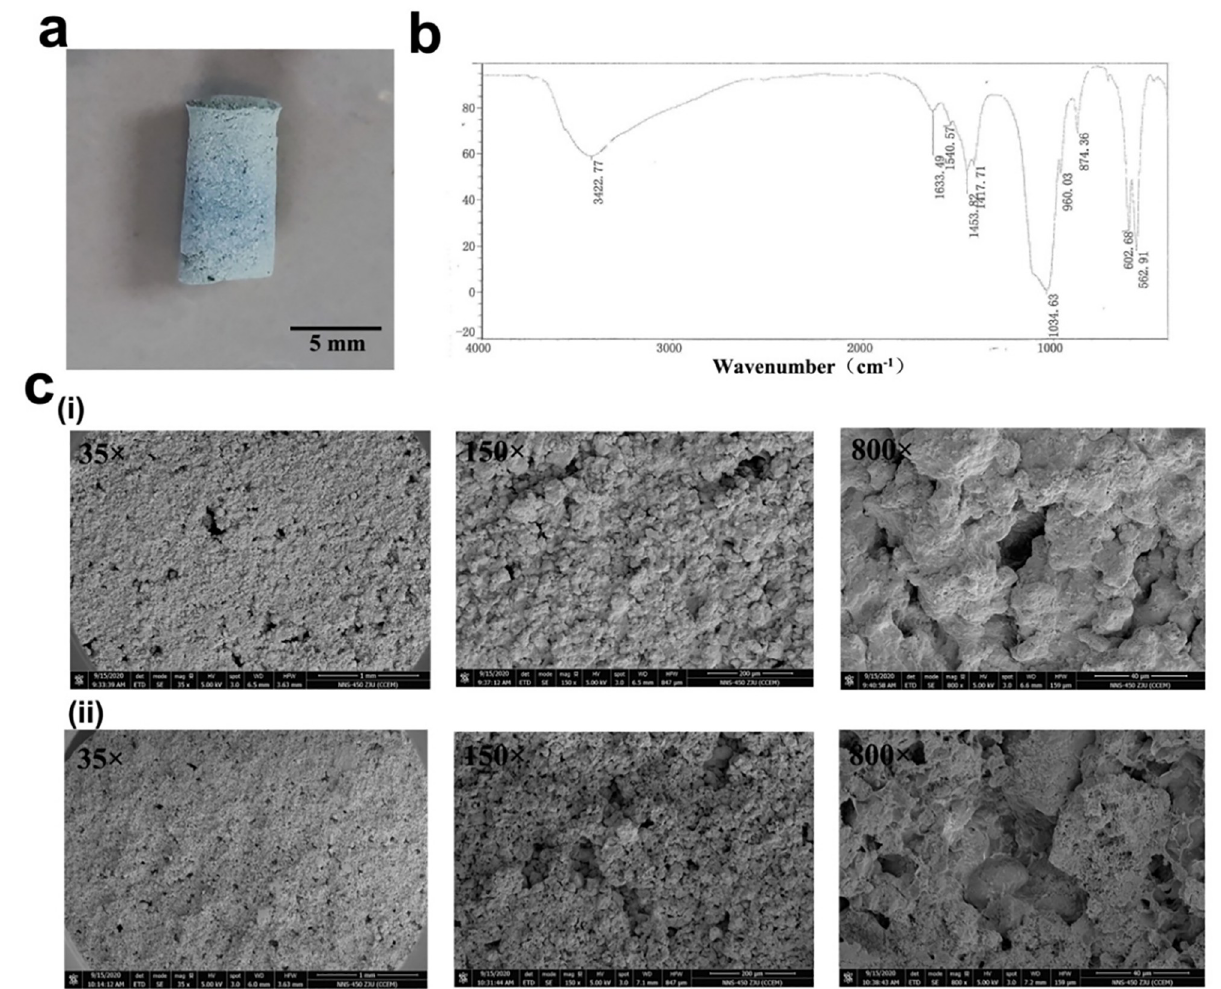
Fig 3. Characterization of CMs(GM)- β -TCP/gelatin composite scaffolds. a Macroscopic observation of CMs(GM)- β -TCP/gelatin composite scaffolds. b FTIR spectra for the β -TCP/gelatin composite scaffolds. c SEM images of (i) CMs- β -TCP/gelatin composite scaffolds (left to right: Scale bars = 1 mm, 200 μ m, and 50 μ m, respectively) and (ii) CMs(GM)- β -TCP/gelatin composite scaffolds (left to right: Scale bars = 1 mm, 200 μ m, and 50 μ m, respectively). (CMs: Chitosan microspheres; GM: Gentamycin; β -TCP: β -tricalcium phosphate; SEM: Scanning electron microscopy; FTIR: Fourier transform infrared